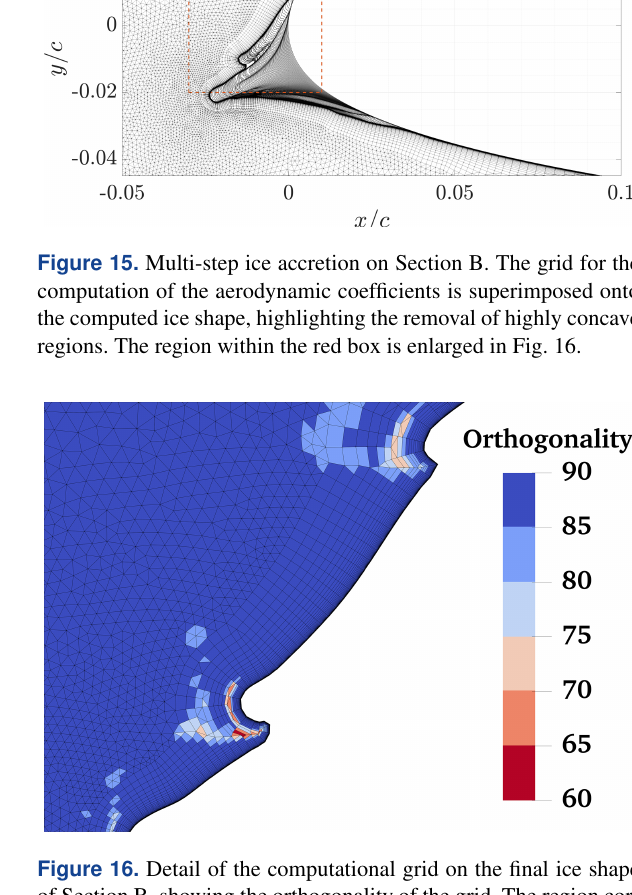
Table 5. Local boundary conditions of the five sections under anal- ysis.